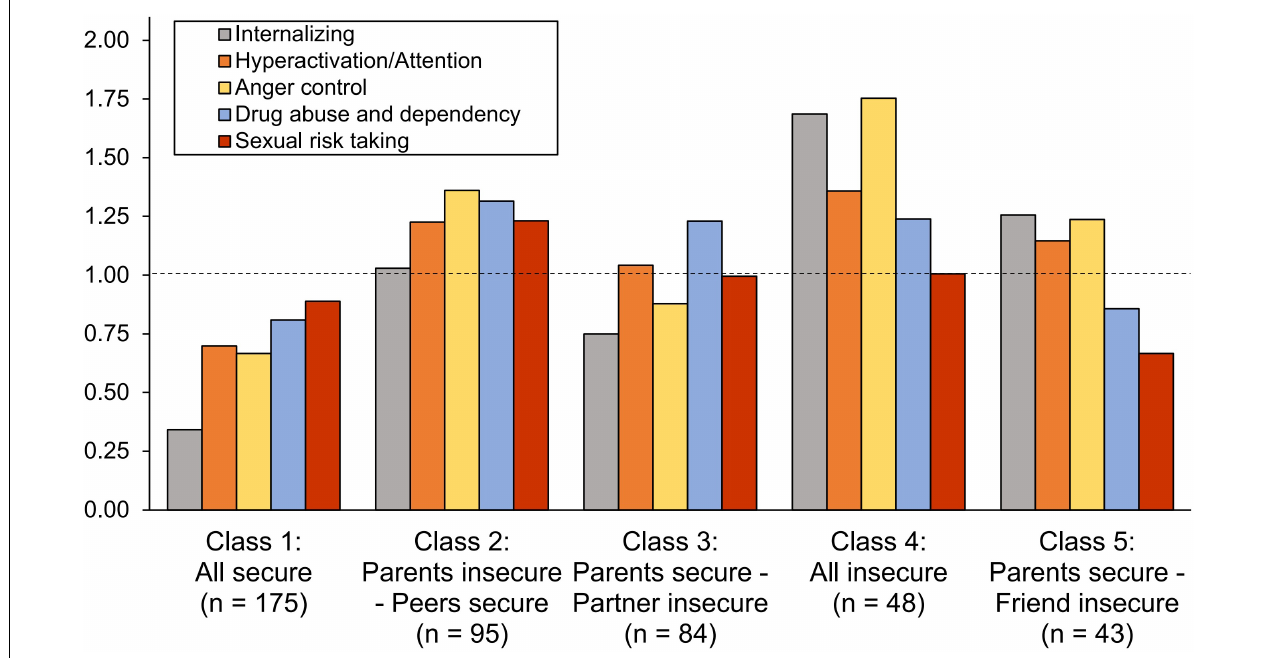
FIGURE 2 | Mean estimates of mental health problems and risks for adolescent latent attachment profiles. The bars represent standardized (M = 1.0, SD = 1.0) scores with mean level indicated by dotted line.